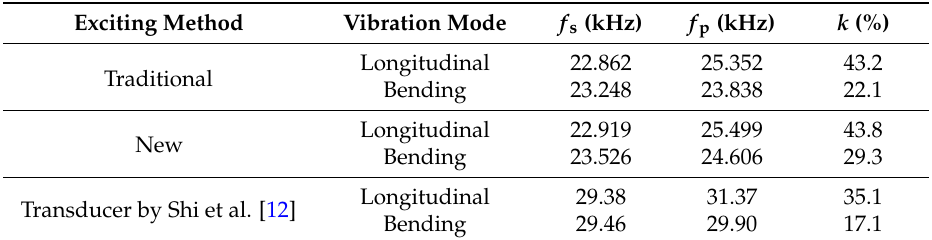
Table 1. The calculated resonance frequencies and electromechanical coupling factors under different exciting methods.